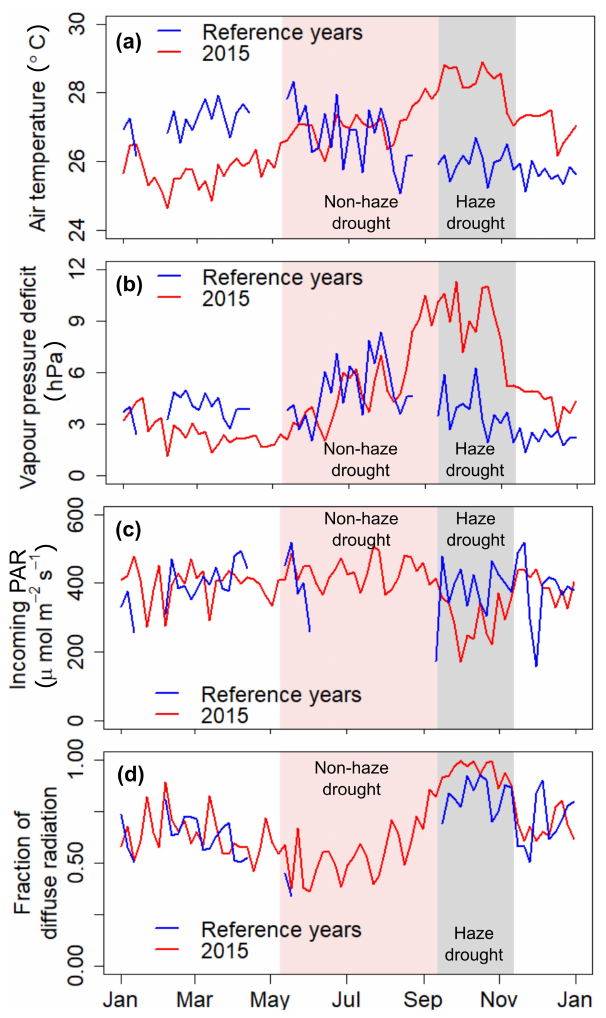
Figure 2. The 5d running mean of air temperature (a) , atmospheric vapour pressure deficit (VPD) (b) , incoming photosynthetically ac- tive radiation (PAR) (c) and fraction of diffuse radiation (d) during 2015 and the reference time period. Shaded areas in red and grey mark the non-haze drought and the haze drought periods in 2015,